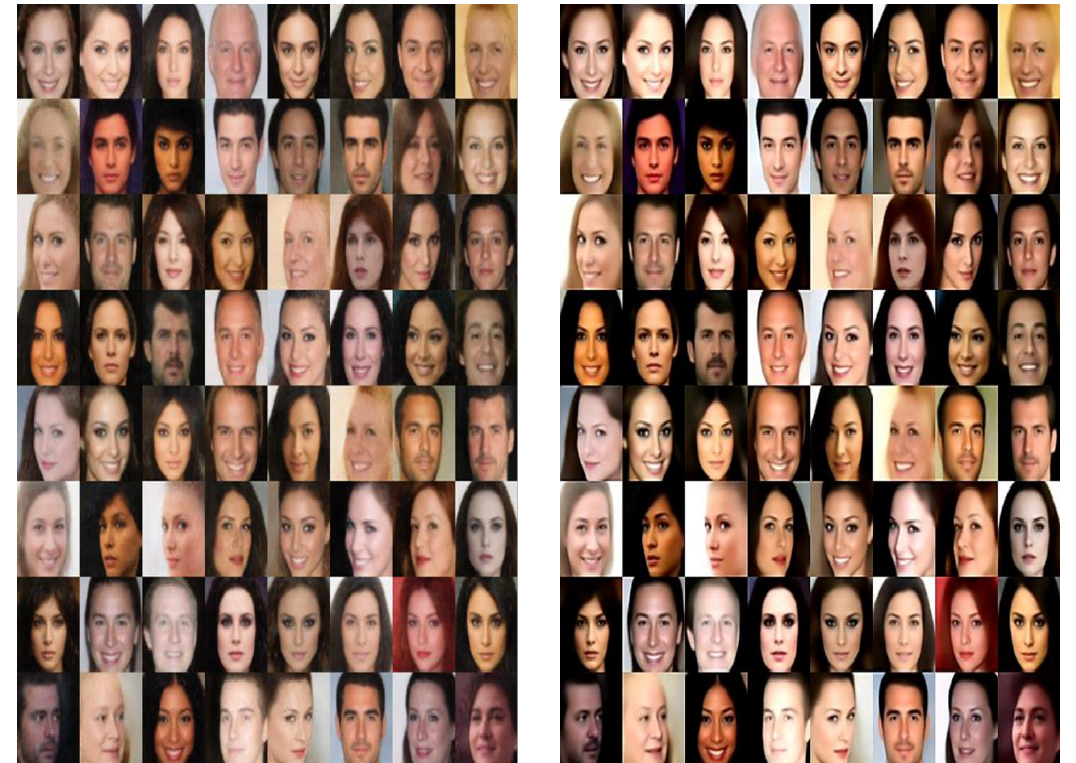
Figure 14. Representative images of 𝐺 ( left ) and 𝑉𝐴𝐸 ( right ) in the proposed model (L2 loss).